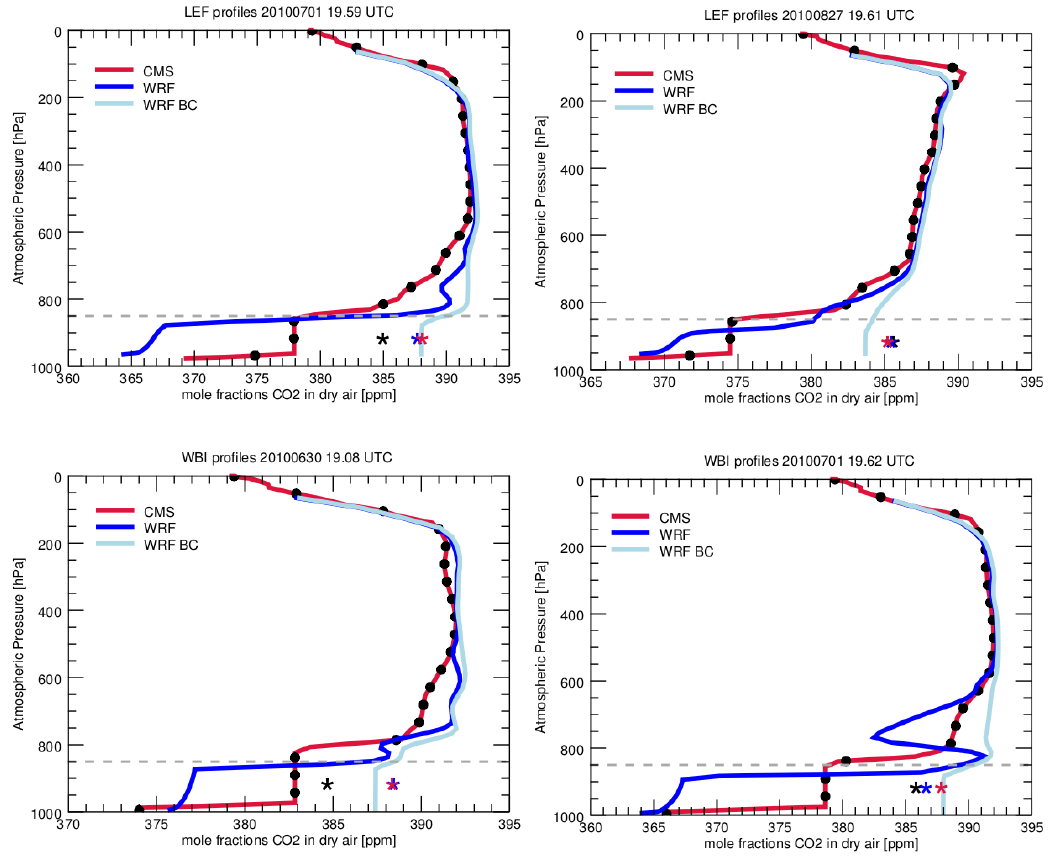
Figure 11. Comparison of modeled CO 2 mole fractions (in ppm) sampled at the location of WBI (West Branch, Iowa) and Park Falls, Wisconsin (LEF) from CMS-Flux (in red), the contribution in CO 2 mole fractions by the CMS boundary conditions in WRF (in light blue), and the total CO 2 mole fractions from WRF (in dark blue). The corresponding total column XCO 2 mole fractions for each profile are indicated by the star